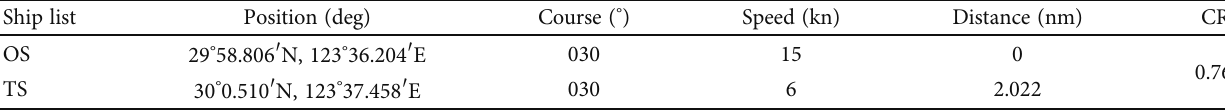
Figure 13: The simulation results under head-on encounter situation. Table 7: Initial information of the ships for overtaking